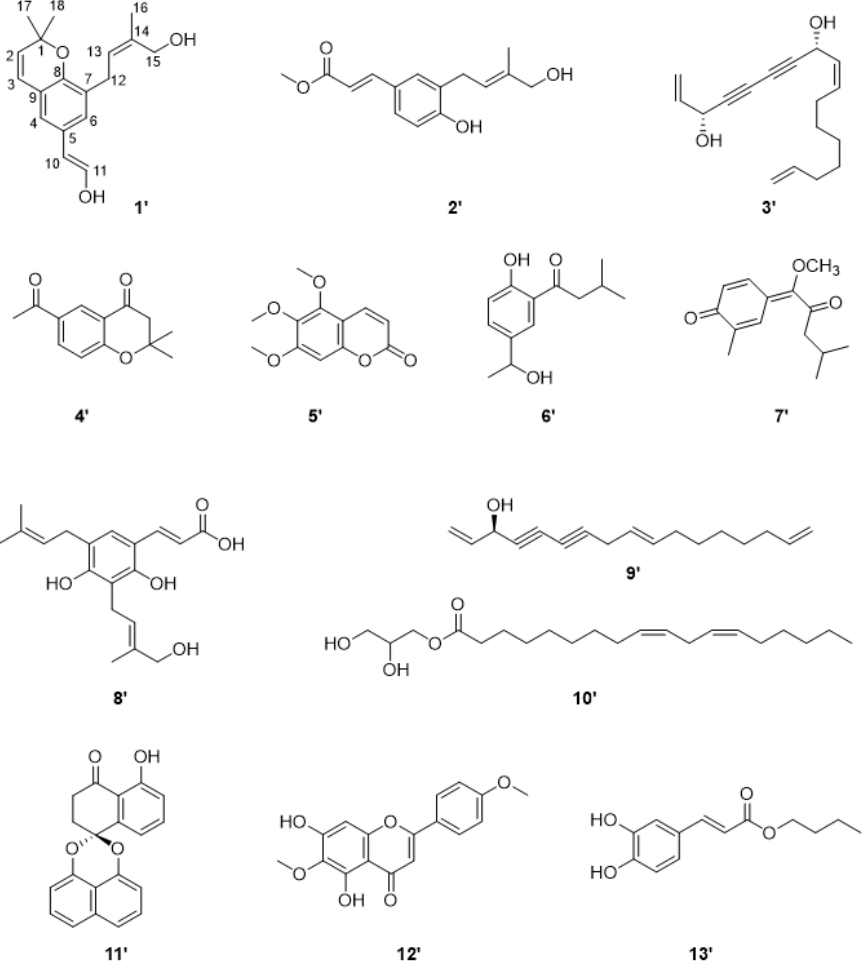
Figure 5. Chemical structures of compounds 1 ’– 13 ’ of A. marschalliana.